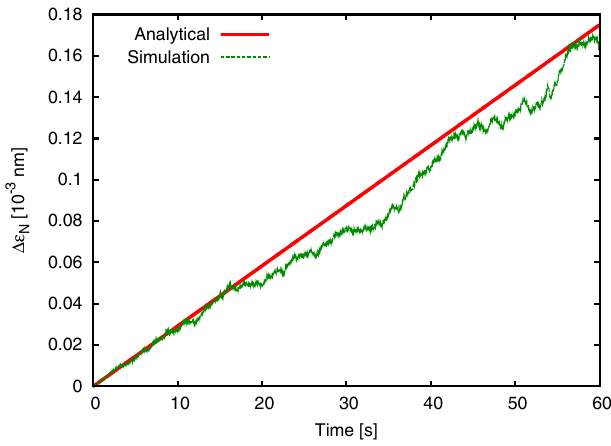
FIG. 7. (Color) Average emittance growth during 1 min (9000 pulses) for 50 random seeds. Only ground motion and feedbacks with ideal BPMs were included. The simulations agree well with the analytical prediction.